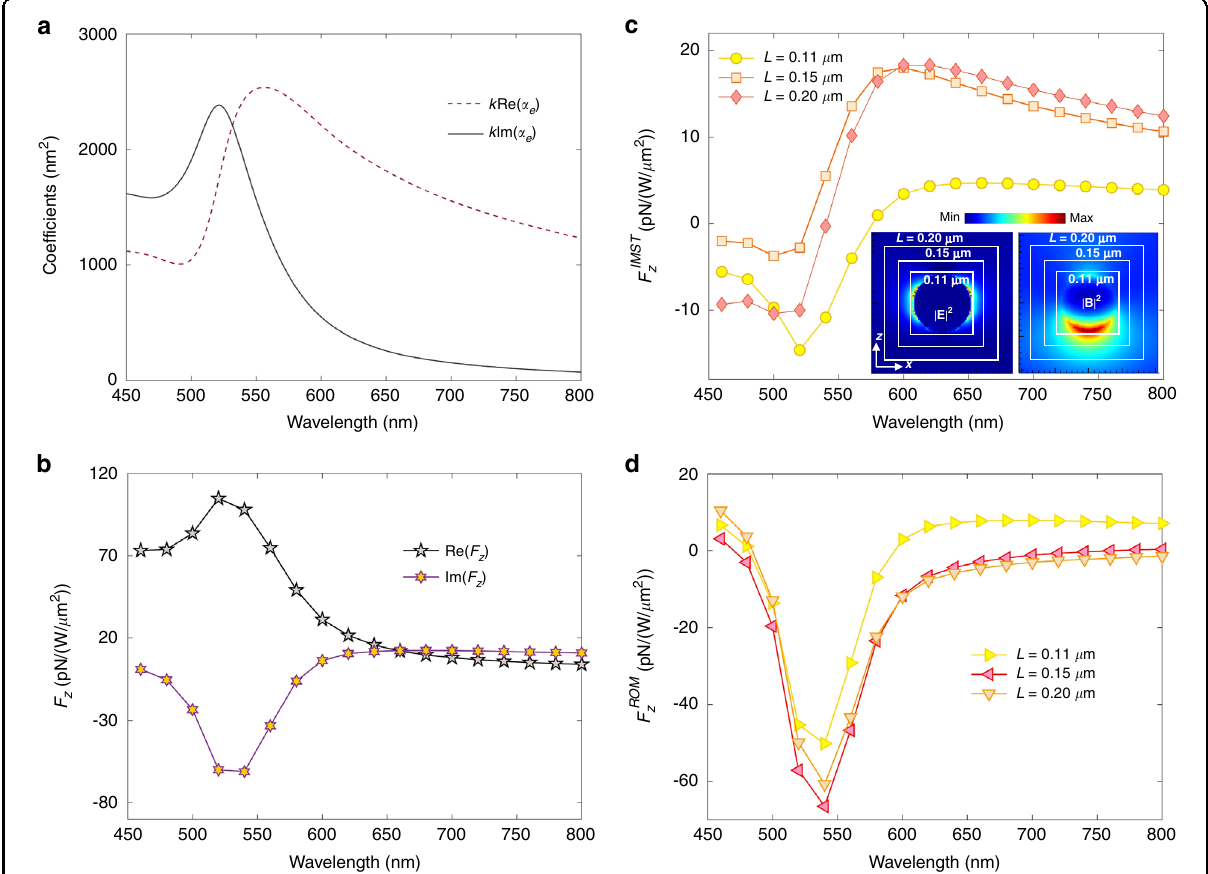
Fig. 4 Linearly polarized propagating plane wave incident on an Au sphere of radius a = 50 nm. E 0 = 1. a Polarizability calculated via Mie theory. b Numerical results for the time-averaged force < F z > and reactive force F I calculated with different cube integration contours. Insets show the spatial distribution on the x = 0 plane of the electric and magnetic fi eld intensities at the wavelength of 540 nm. White broken line squares illustrate the integration contours. d ROM component, F ROM from F I by subtracting F IMST z